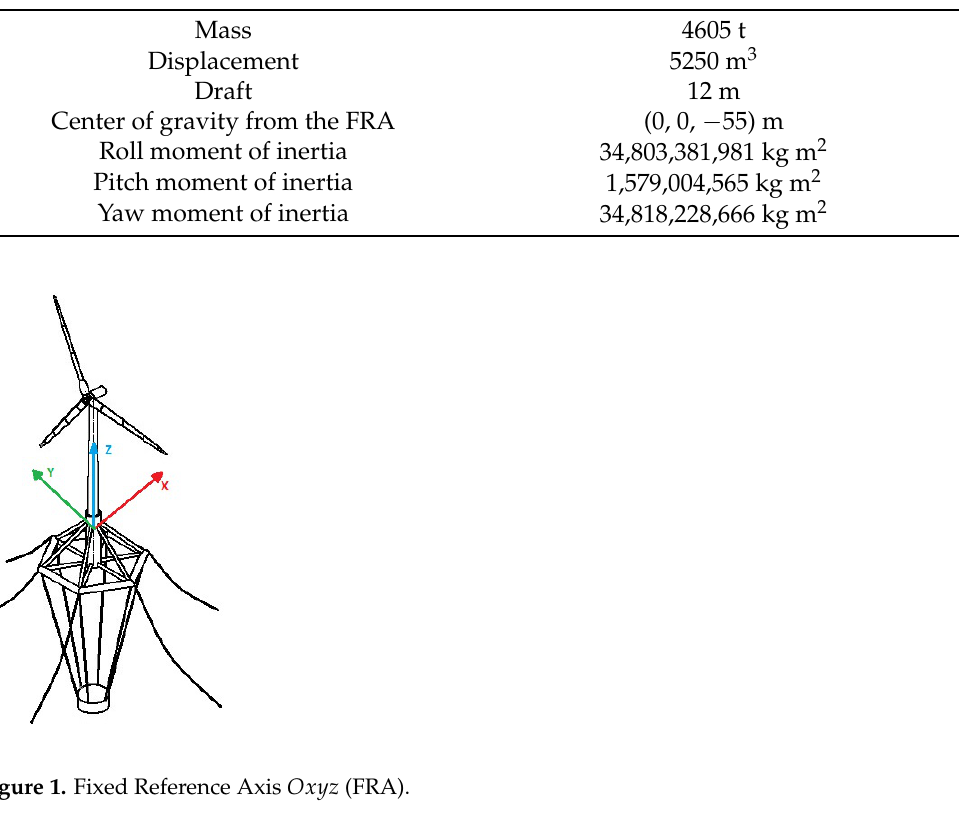
Table 1. Undistributed blade aerodynamic and structural properties.